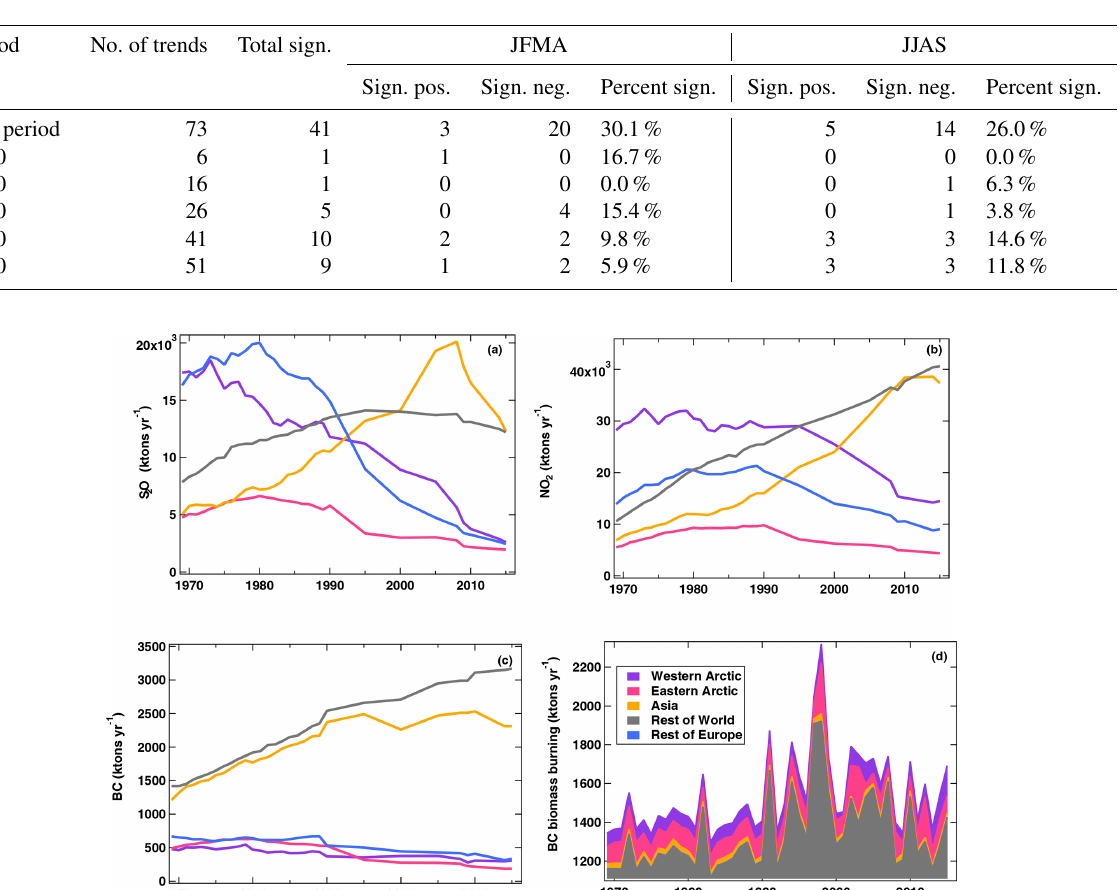
Table 4. Summary of derived significant trends per season (JFMA and JJAS) for the full period of each data set and per decade. The percentage of significant (sign.) trends is calculated from the total number of trends (column 2) evaluated for the given time period. There are 26 significant decadal trends.